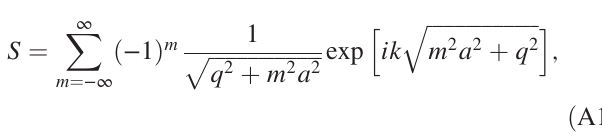
FIG. 11. Wakefields for a Gaussian bunch with σ z ¼ 0 . 5 mm (the bunch profile is shown by red dotted line): calculated with CSRZ (blue line) and with the analytical model (red line) using impedances shown in Fig. 10. The dashed magenta shows the numerically calculated wake for the aspect ratio b=a ¼ 16 . The bunch head is to the right; positive wake corresponds to the energy